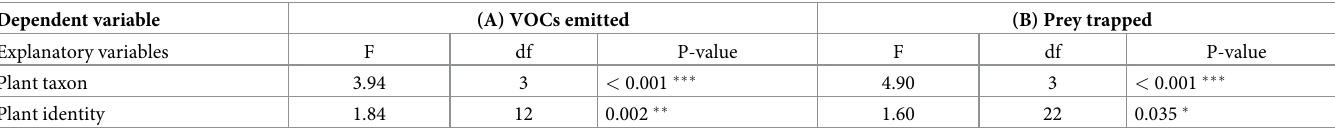
Table 1. Result of similarity analyses of odour and prey composition of the Sarracenia taxa. Dependent